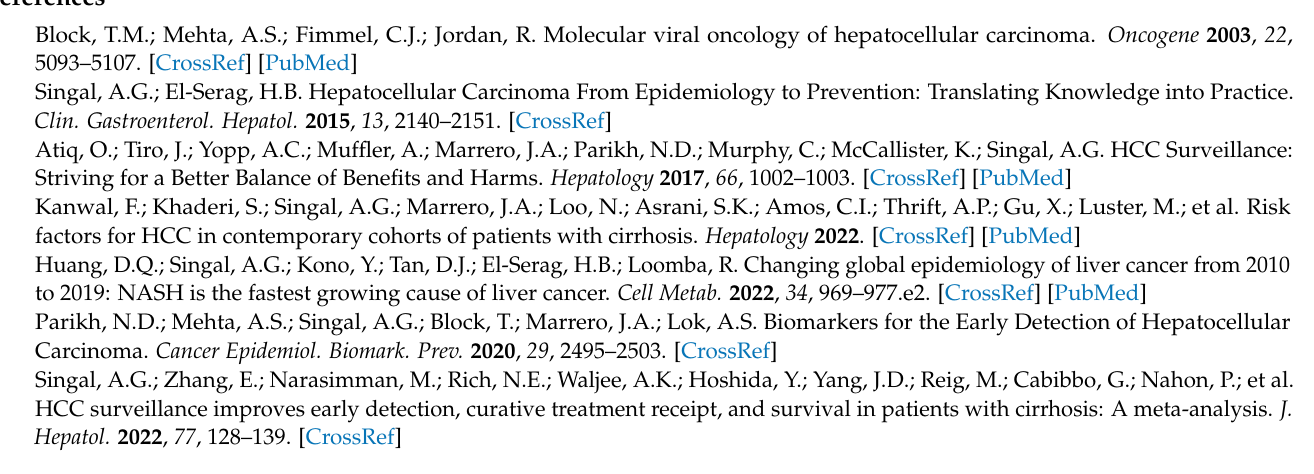
Abcam anti-IgG; Figure S5: Performance of biomarkers in patients treated for the HCC, Asterisk indicated statistical difference (Mann Whitney, p < 0.05); Figure S6: AUROC of PEG-IgG in the UM cohort in patients at a time point of 1–6 months prior to HCC development; Figure S7: AUROC of PEG-IgG in the UM cohort in patients at a time point of 7–12 months prior to HCC development; Figure S8: AUROC of AFP in the UM cohort in patients at a time point of 1-6 months prior to HCC development; Figure S9: AUROC of AFP in the UM cohort in patients at a time point of 7–12 months prior to HCC development; Supplementary Figure S10: AUROC of fucosylated kininogen in the UM cohort in patients at a time point of 1–6 months prior to HCC development; Figure S11: AUROC of fucosylated kininogen in the UM cohort in patients at a time point of 7–12 months prior to HCC development; Figure S12: Workflow of model development; Figure S13: AUROC of model in the UT cohort; Figure S14: AUROC of model in SLU cohort; Supplementary Figure S15: AUROC of model in UCSD cohort; Figure S16: External validation of model in the UM cohort in patients at a time point of 1–6 months prior to HCC development; Figure S17: External validation of model in the UM cohort in patients at a time point of 7+ months prior to HCC development; Figure S18: AUROC of Peg-IgG in the UM cohort in patients at patients with cancers falling within Milan criteria; Figure S19: AFP AUROC in the UM cohort in patients with cancers falling within Milan criteria; Figure S20: Fucosylated kininogen AUROC in the UM cohort in patients with cancers falling within Milan criteria. Supplementary Table S1. Comparison of previously published algorithms and the PEG-IgG related